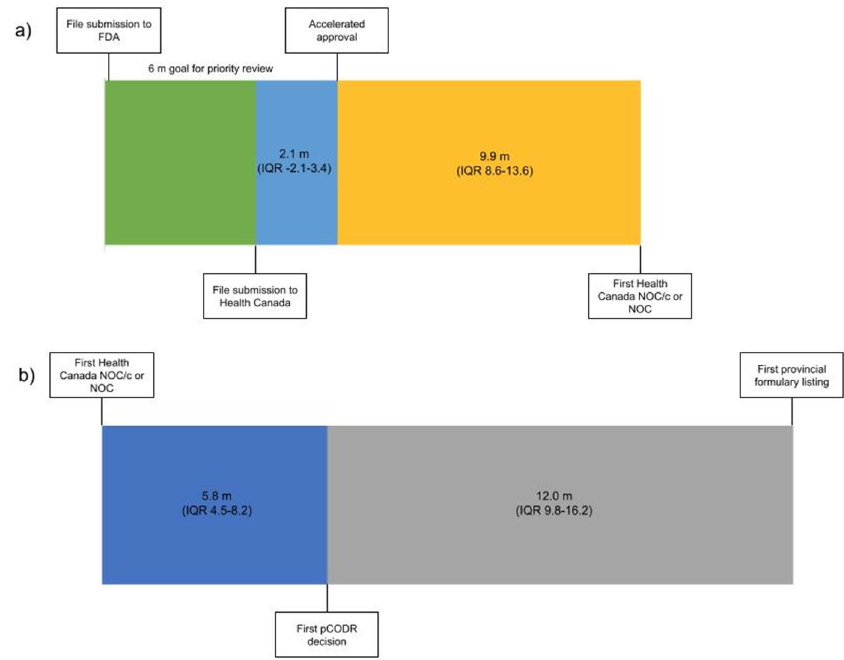
Figure 1. Timeline from ( a ) file submission to FDA to Health Canada NOC/c or NOC Figure 2000 ( n = 70) and ( b ) from Health Canada NOC/c or NOC to the first provincial formulary listing after the adoption of the pCODR process 2011–2019 ( n = 32). Median duration in months. (m—months, IQR—interquartile range).